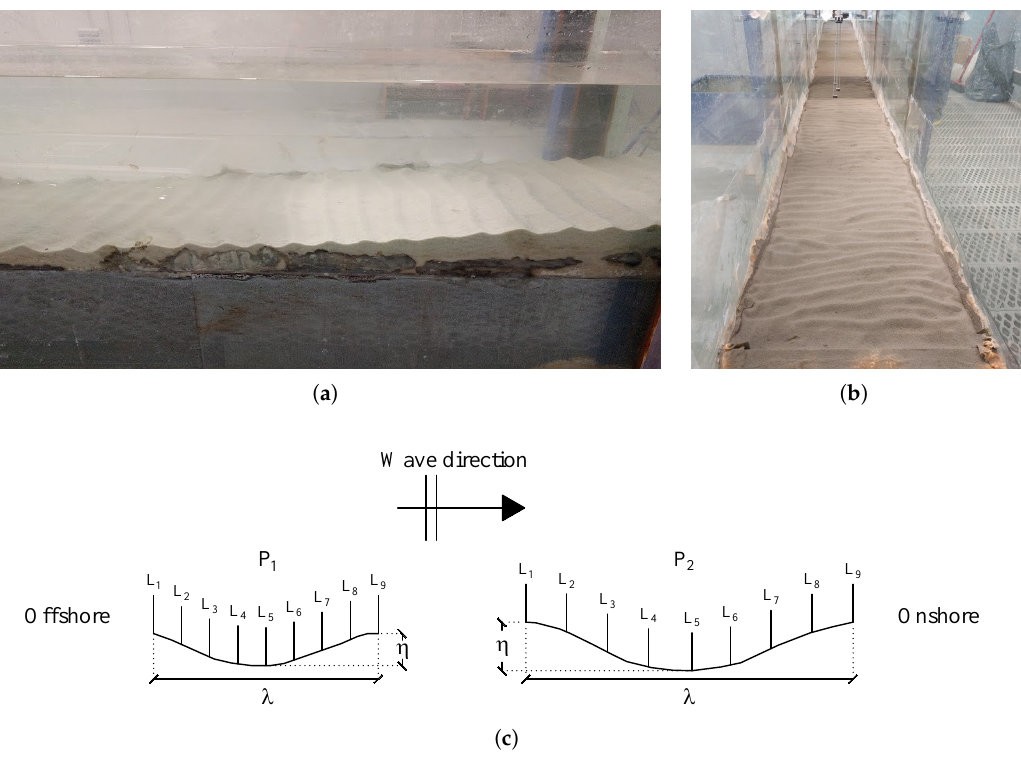
Figure 2. The rippled bed: ( a ) picture of the bed at the equilibrium condition; ( b ) picture of the fixed bed after the sieving process; and ( c ) ripples P 1 (flat bed) and P 2 (sloping bed). L 1 – L 9 indicate the positions of the nine vertical measuring locations at ripples P 1 and P 2 , λ being the ripple wavelength